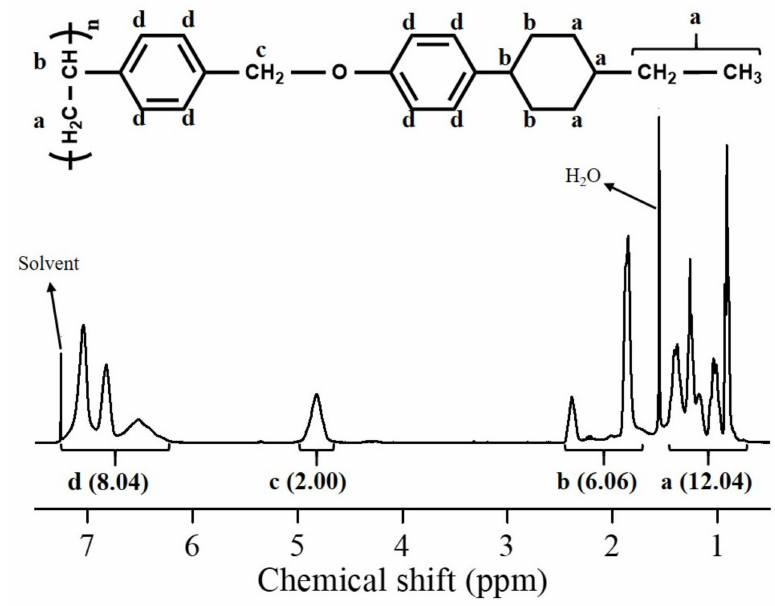
Figure 2. 1 H nuclear magnetic resonance (NMR) spectrum of PECH.